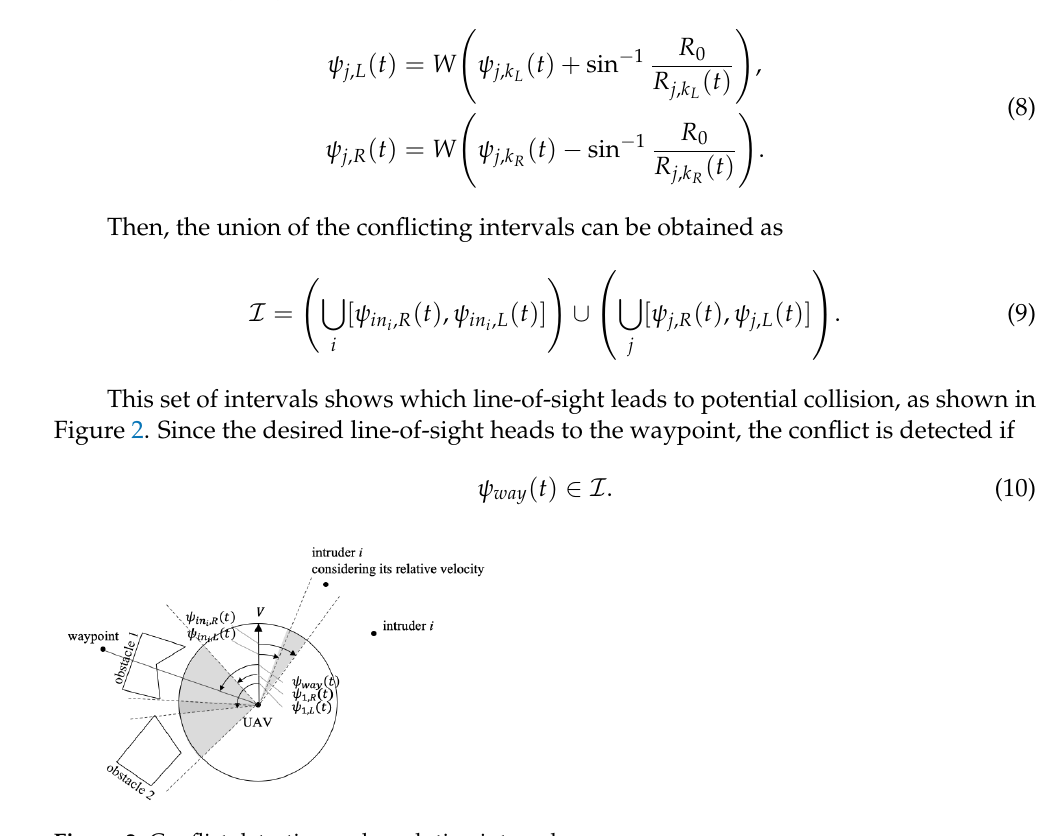
Figure 2. Conflict detection and resolution